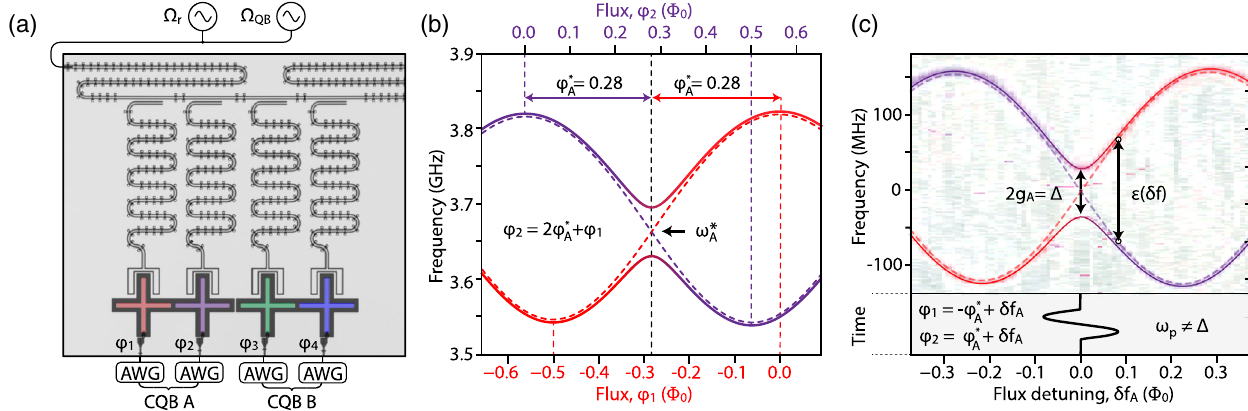
FIG. 1. Device and control. (a) Optical micrograph of two composite qubits (CQB-A and CQB-B) comprising four transmon qubits (1, 2, 3, and 4) with nearest-neighbor capacitive coupling. A microwave feedline allows frequency multiplexed readout and state preparation via the microwave driving fields Ω and Ω , respectively. (b) Eigenenergies of individual (dashed lines) and coupled (solid r QB lines) asymmetric-junction transmons 1 and 2 (CQB-A). An avoided level crossing occurs when the coupled transmons are resonantly φ (cid:2) biased at φ 1 . (c) Upper panel: corresponding measured excited-state spectroscopy centered at zero frequency (offset in ; 2 ¼ (cid:3) A frequency) to form a two-level system model with parameters Δ and ε ð δ f Þ . Near the avoided crossing region, ε is proportional to the flux detuning δ f , realized by simultaneously biasing φ 1 and φ 2 . Lower panel: nonadiabatic control implemented by applying a single period ≠ Δ ) sinusoidal excursion about the avoided of a nonresonant ( ω p